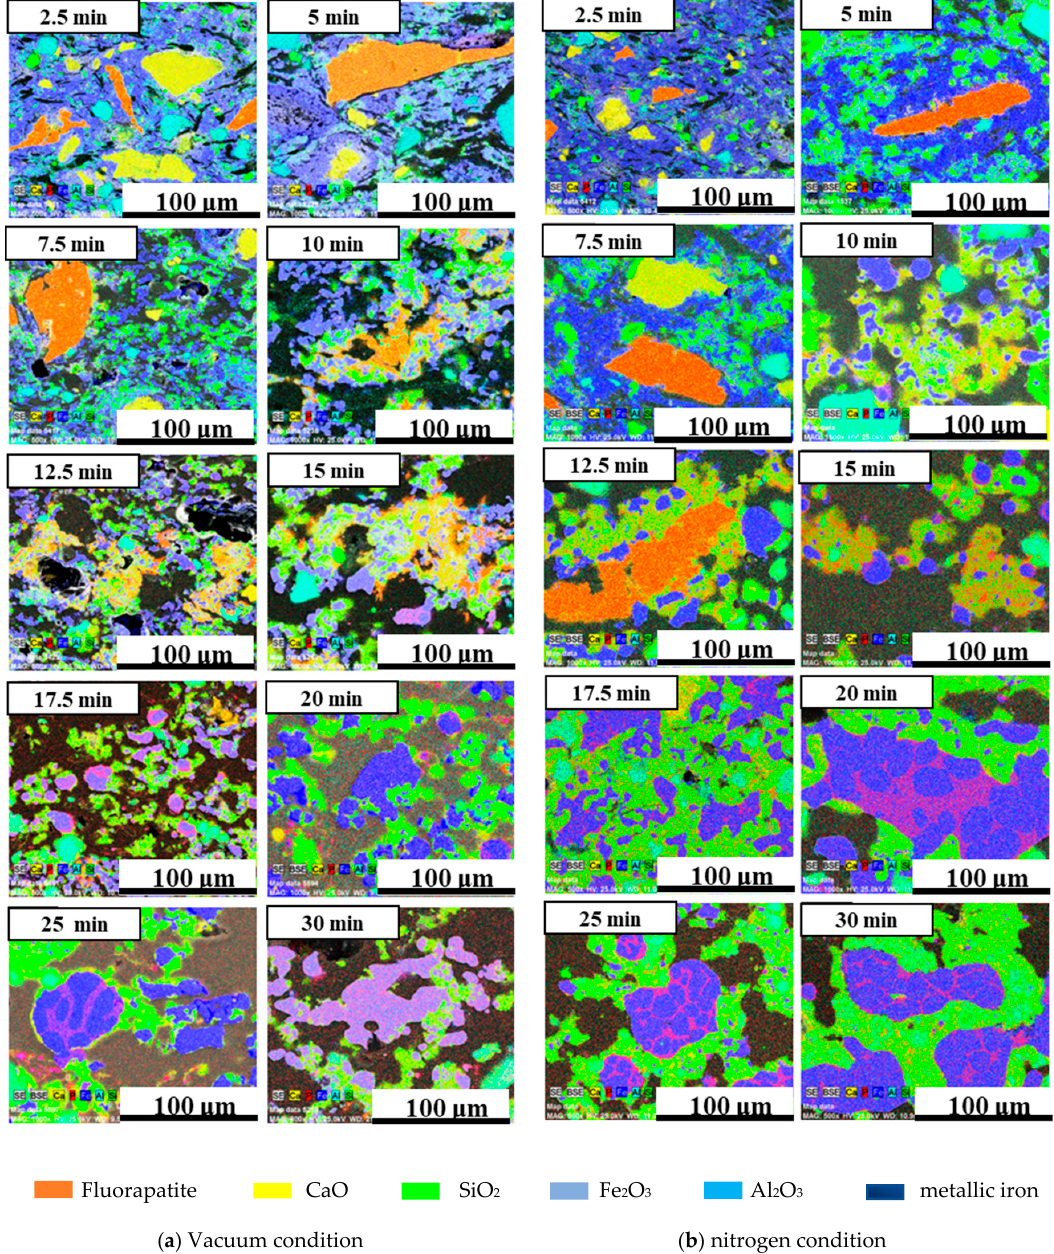
Figure 12. Microscopic changes during the reduction process of high-phosphorus iron ore.